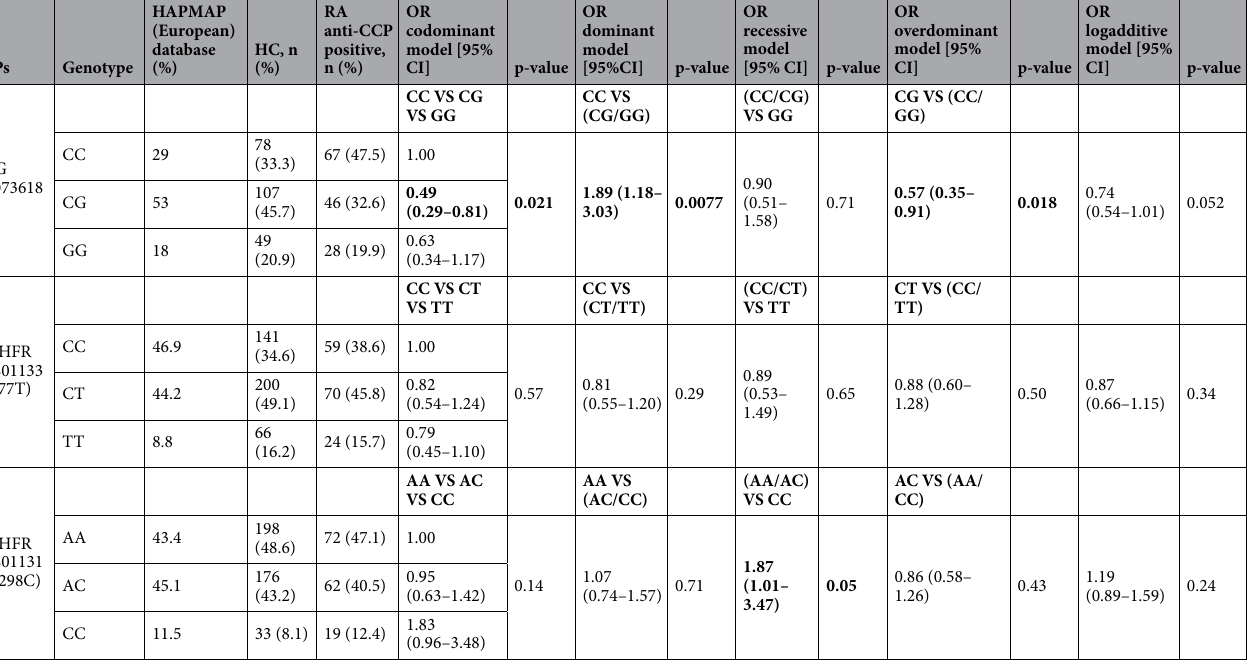
Table 5. Prevalence of the OPG rs2073618 and the MTHFR rs1801133 and rs1801131 SNP genotypes in RA anti-CCP positive patients and HC, adjusted by gender and age. Genotypes, OR and p-value for the five genetic models (codominant, dominant, recessive, overdominant and additive) were estimated with SNPstats software (statistically significant if p < 0.05). OPG osteoprotegerin, MTHFR methylene tetrahydrofolate reductase, OR odds ratio, SNP single nucleotide polymorphism, VS versus, RA rheumatoid arthritis, HC healthy controls, anti-CCP anti-cyclic citrullinated peptide, HAPMAP haplotype map. Significant values are in bold.